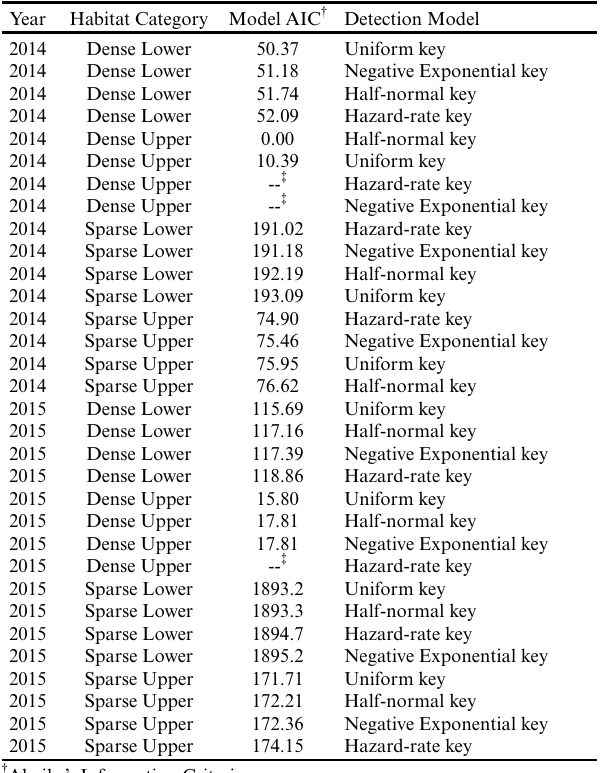
Table 3 . Density model selection within program DISTANCE for Kori Bustards ( Ardeotis kori ) in each habitat type surveyed June– July 2014 and May–July 2015 within the Northern Tuli Game Reserve, Botswana. All detection models run with cosine